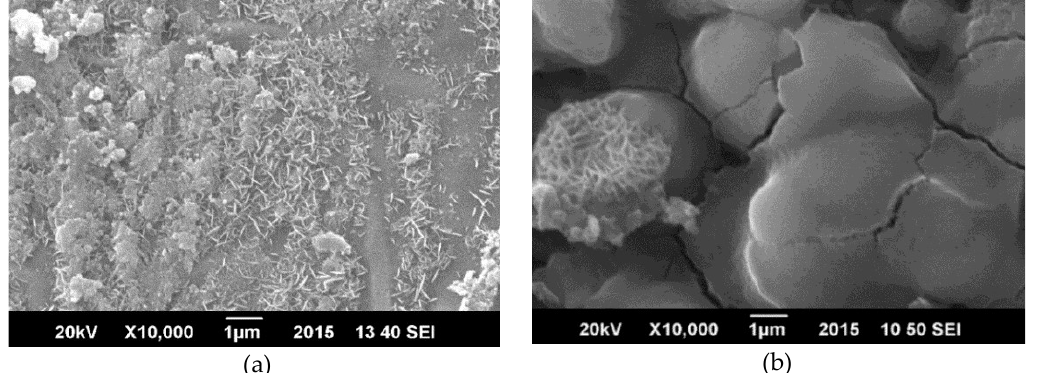
Figure 6. SEM micrographs-ZnO/GO coated samples in seawater ( a ) Before corrosion test; ( b ) After corrosion test.